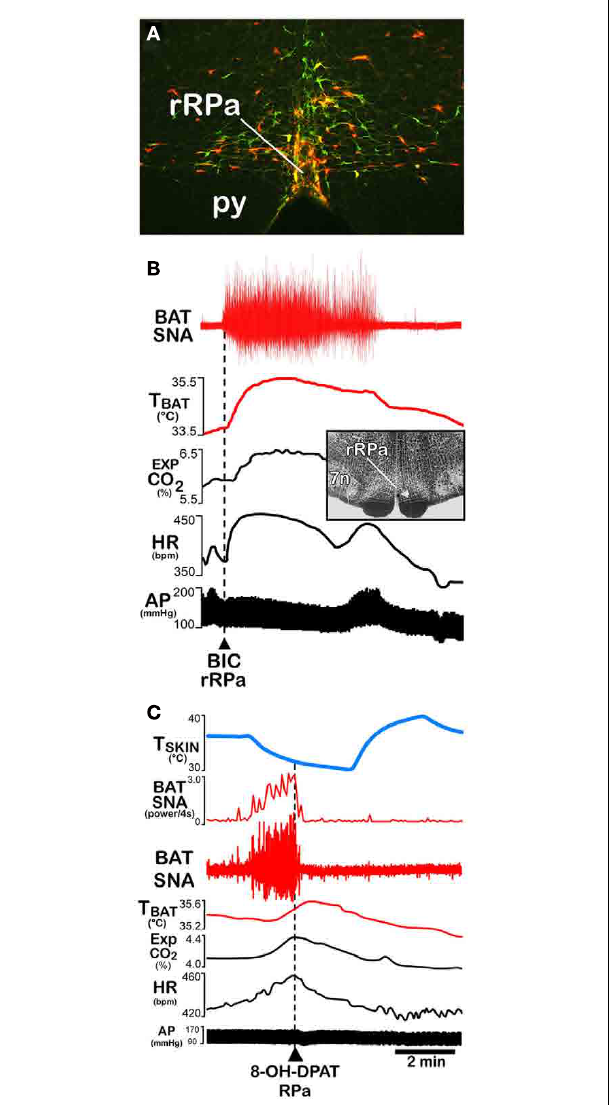
FIGURE 4 | Effects of disinhibition and inhibition of rostral raphe pallidus (rRPa) neurons on brown adipose tissue (BAT) thermogenesis. (A) Coronal histological section through the rostral medulla at the level of the facial nucleus and the rRPa, containing immunohistochemically labeled neurons that were trans-synaptically infected following inoculations of BAT with pseudorabies virus (red), that contain the serotonin synthesizing enzyme, tryptophan hydroxylase (green), or that contain both markers (yellow). Py, pyramidal tract. Modified with permission from Cano et al. (2003). (B) Disinhibition of neurons in the rRPa [arrowhead in inset histological section through rRPa at the level of the facial nucleus (7n)] with nanoinjections of bicuculline (BIC) elicits dramatic increases in BAT sympathetic nerve activity (SNA), BAT temperature (TBAT), expired CO 2 (Exp CO 2 ), and heart rate (HR), with little change ion arterial pressure (AP). Modified with permission from Madden and Morrison (2003). (C) Inhibition of local neurons in the rRPa with a nanoinjection of the inhibitory serotonin 1A receptor agonist, 8-OH-DPAT, produces a rapid and complete reversal of the skin cooling-evoked increases in BAT SNA and an immediate waning of the accompanying metabolic and cardiac responses, despite the sustained reduction in skin temperature (TSKIN). Modified with permission from Nakamura and Morrison